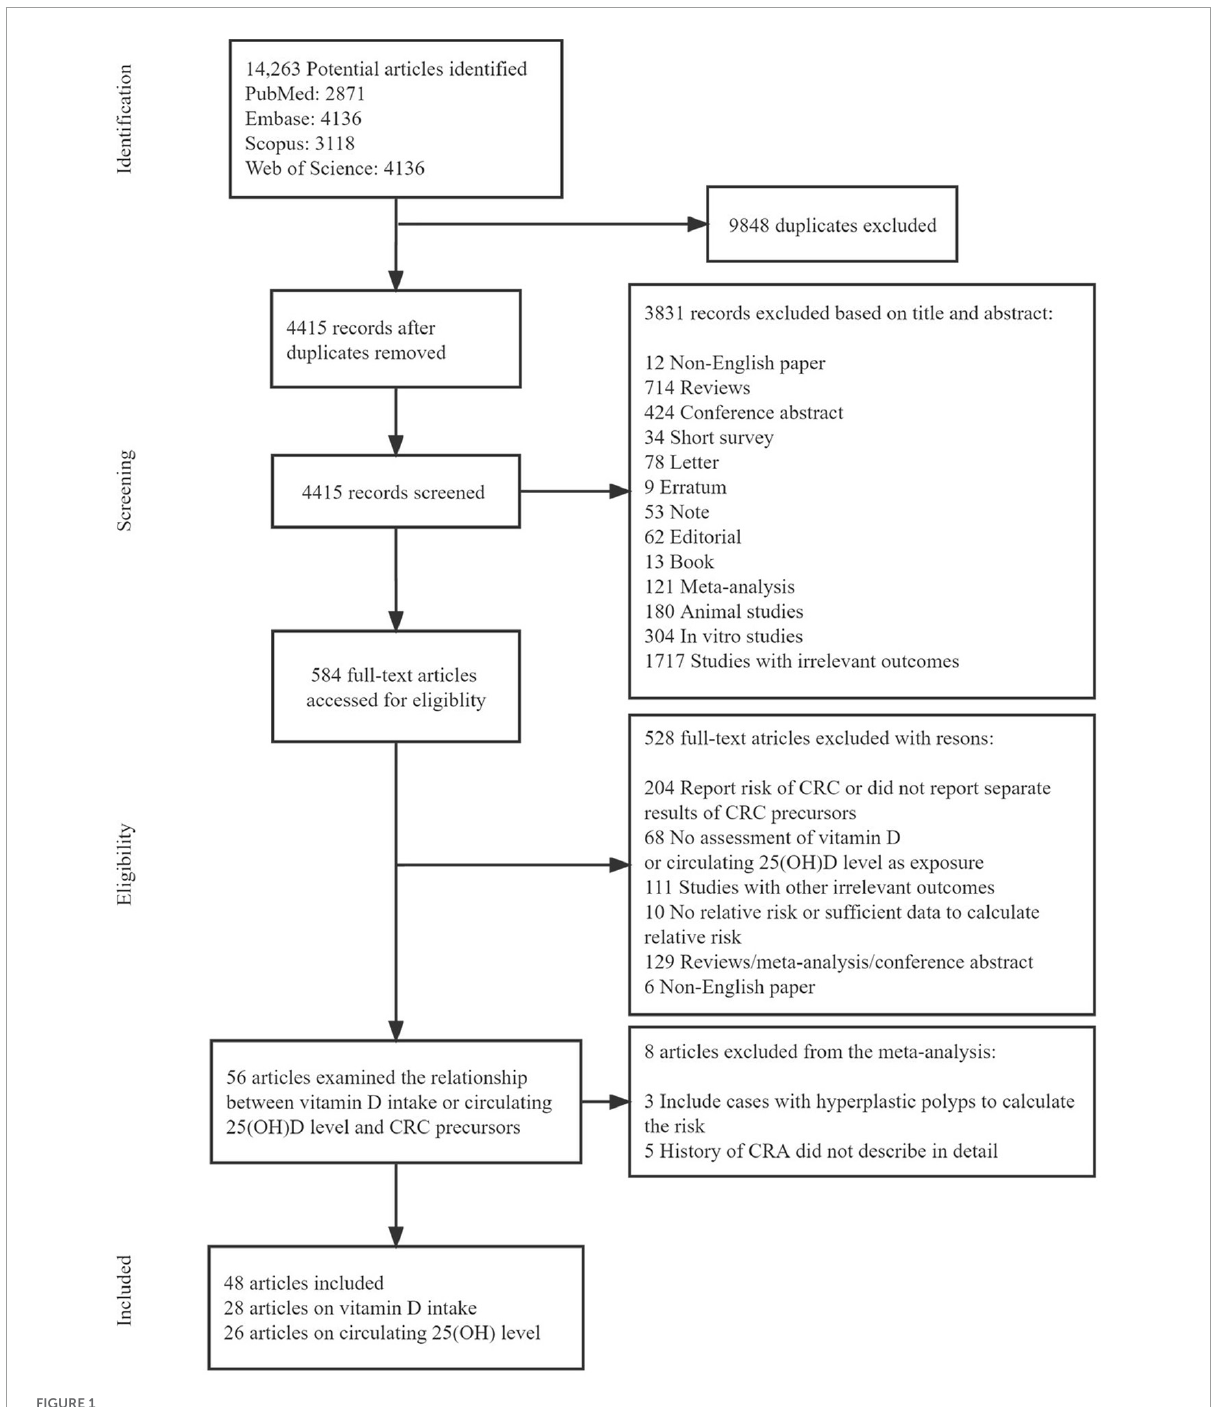
FIGURE1 Flow chart of the studies included in this meta-analysis.